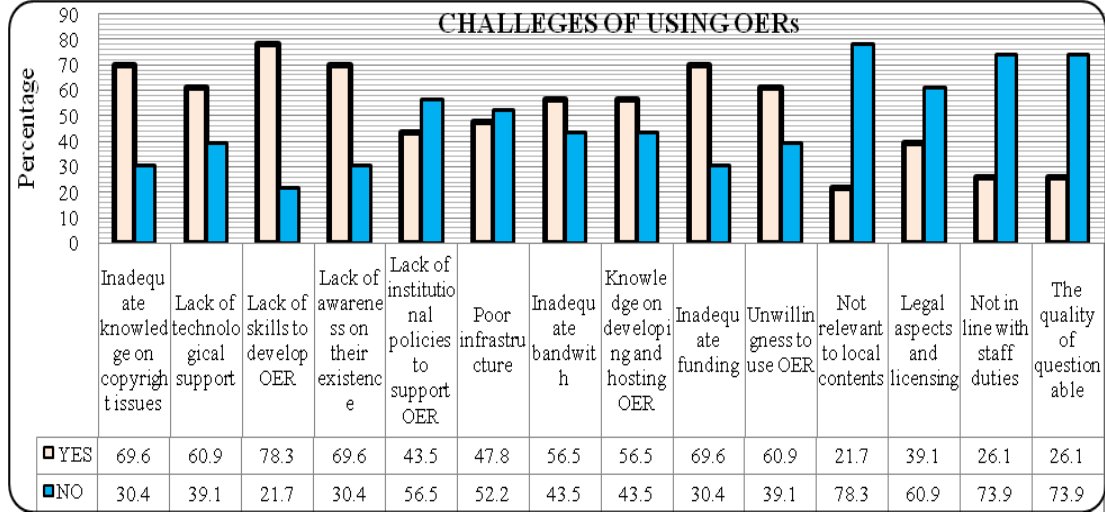
Figure 8. Challenges to using